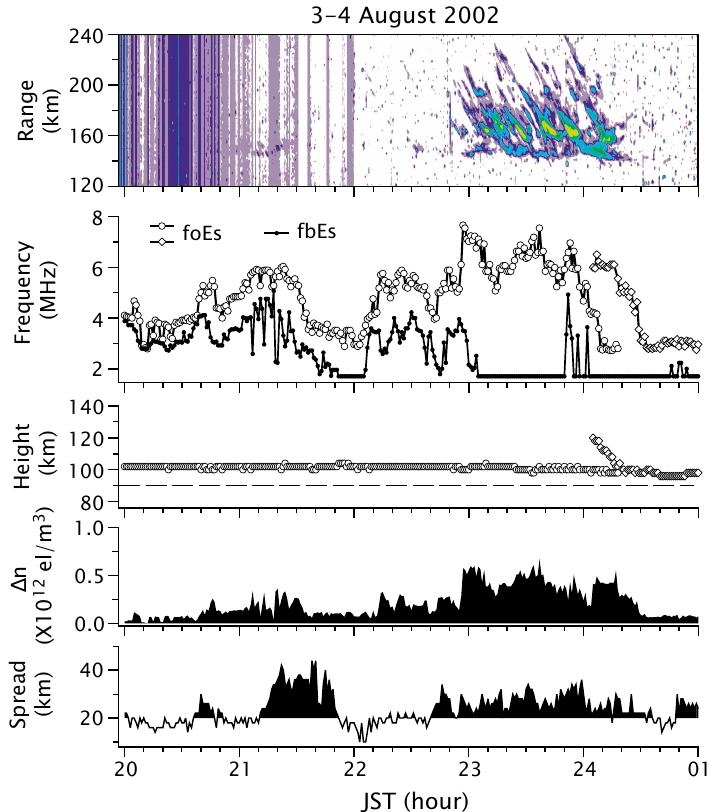
Fig. 3. Range-time-intensity map of Tanegashima South radar (top panel), critical and blanketing frequencies of sporadic E (second panel), virtual height of the sporadic E (third panel), inhomogeneity factor 1 n (fourth panel), and range spread (bottom panel) for the event on the night of 3–4 August